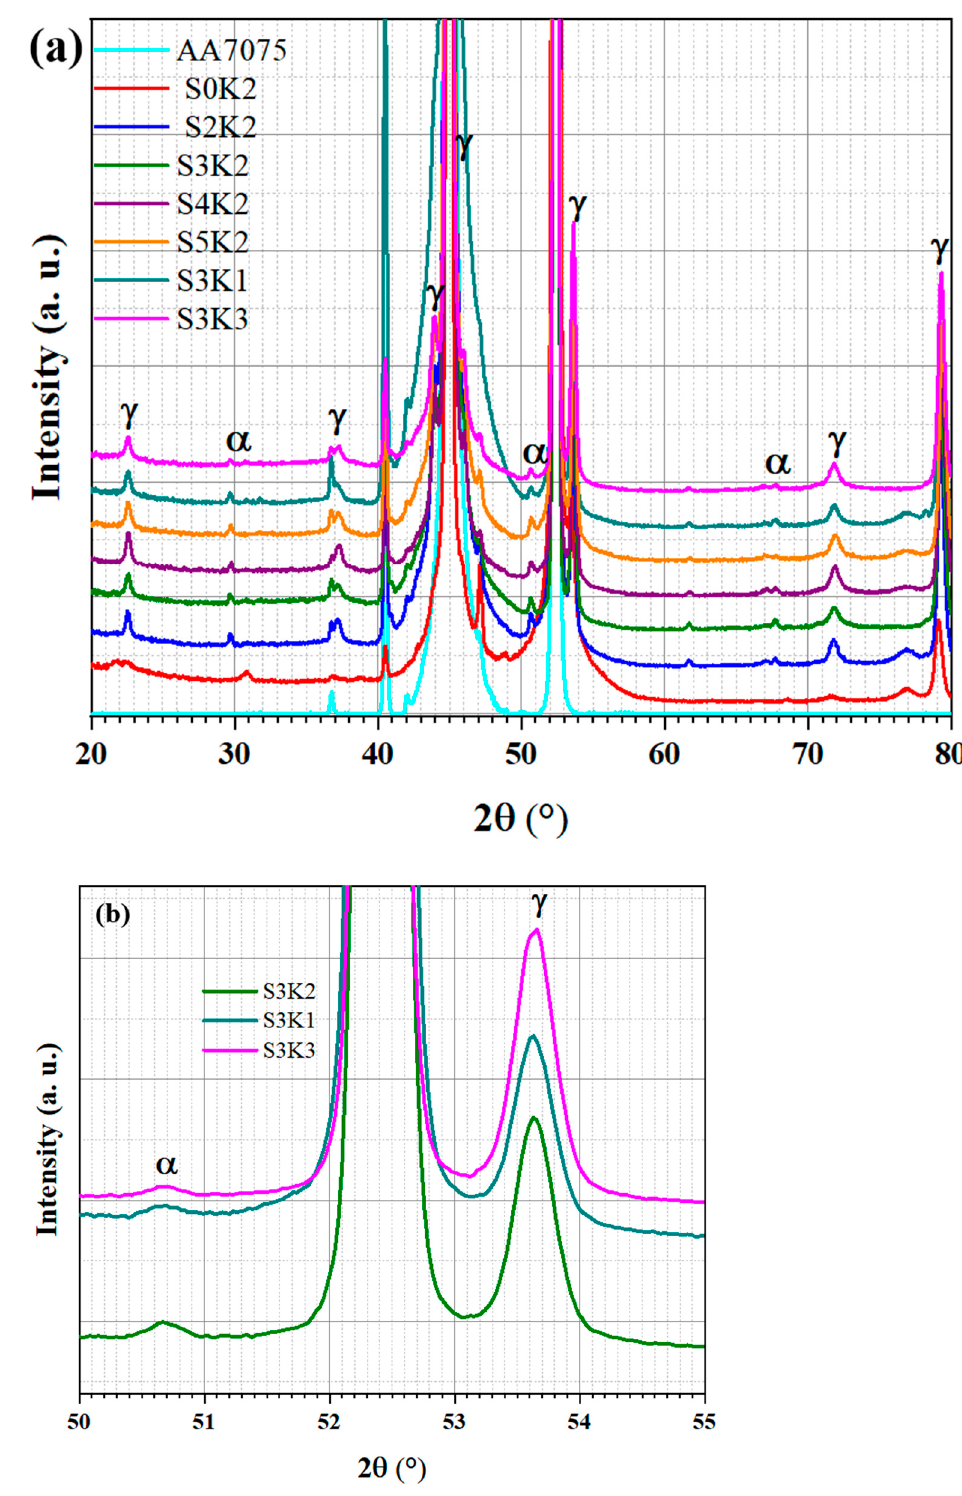
Figure 6. ( a ) XRD patterns of the Al 7075 substrate and the PEO coatings. γ , and α symbols are related to γ -Al 2 O 3 , and α -Al 2 O 3 , respectively. ( b ) shows the magnified (400) and (113) peaks of γ -Al 2 O 3 and α -Al 2 O 3 , respectively, related to S3K1, S3K2, and S3K3 specimens. Since the coatings are porous, strong diffraction peaks of the substrate are detected. As observed, non-stoichiometric γ -Al 2 O 3 (Al 2.667 O 4 , JCPDS card number: 01-080-1385) is